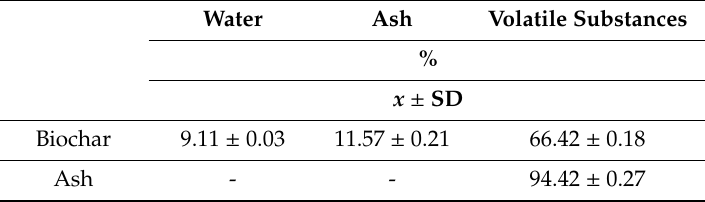
Table 4. Contents of water, ash and volatile substances in the biochar and biomass ash. Water